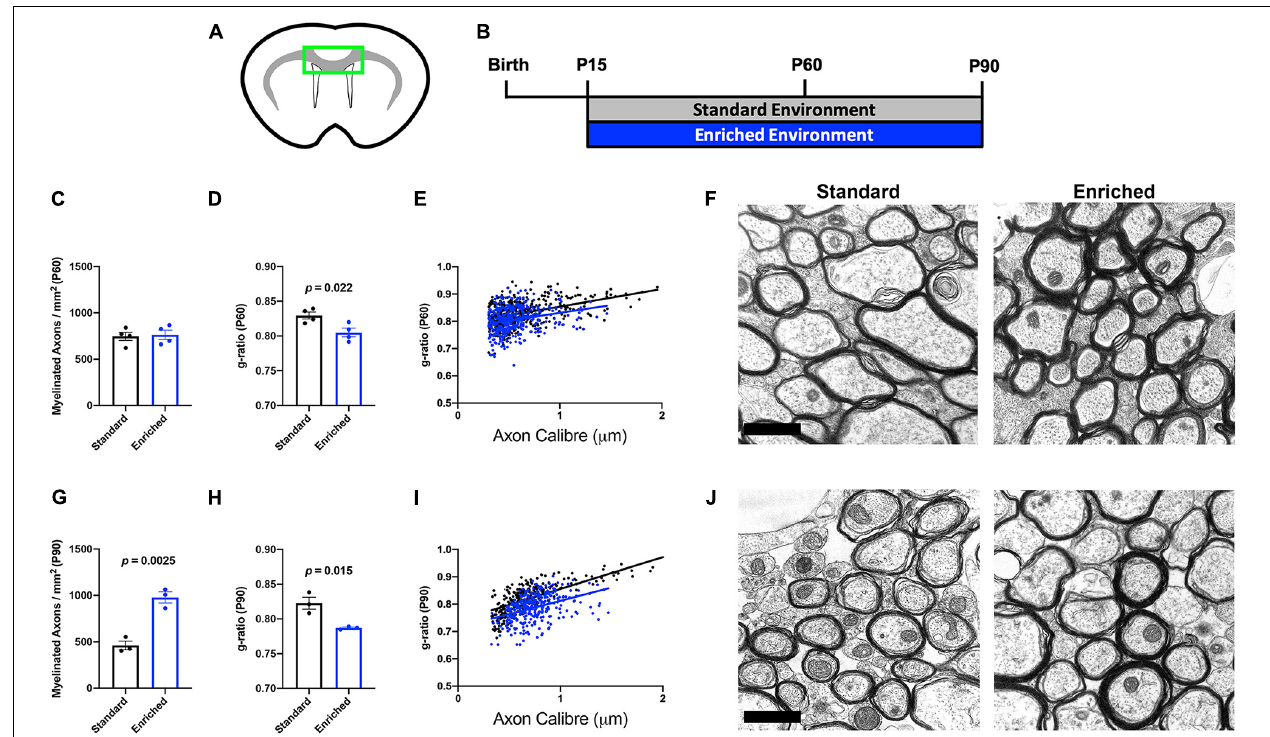
FIGURE 2 | Prolonged EE increases corpus callosum myelination. (A) Schematic depiction of corpus callosum (green box) used for EM analysis. (B) Experimental timeline. (C,G) Number of myelinated axons in the corpus callosum of SD (black) and EE (blue) mice at P60 (C) and P90 (G) . (D,H) Average g-ratio of myelinated axons in the corpus callosum of SD (black) and EE (blue) mice at P60 (D) and P90 (H) . (E,I) Scatter plots depicting the g-ratios of individual corpus callosum axons relative to axon diameters in SD (black) vs. EE (blue) at P60 (E) and P90 (I) . (F,J) Representative electron micrographs from P60 (F) and P90 (J) . Scale bar = 1 µ